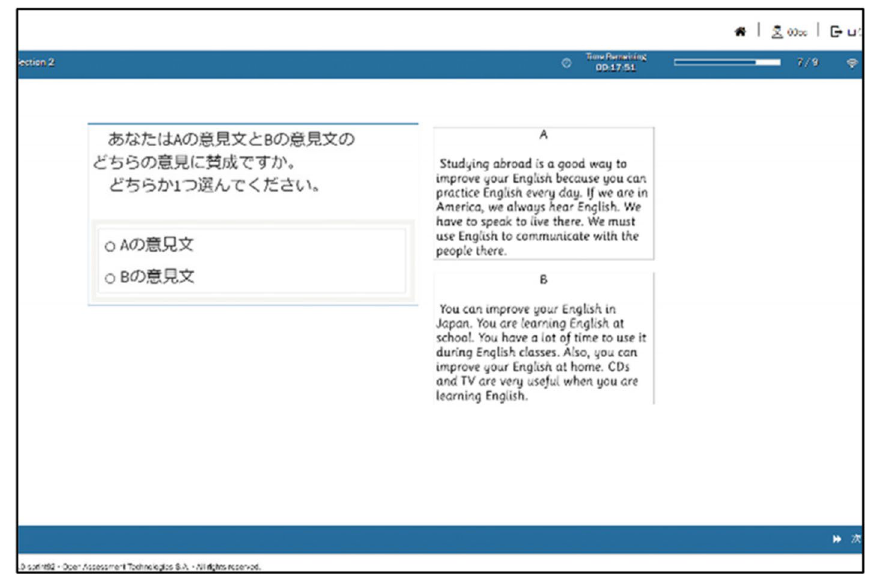
Fig. 6 Screen 5: Choose the source you agree with